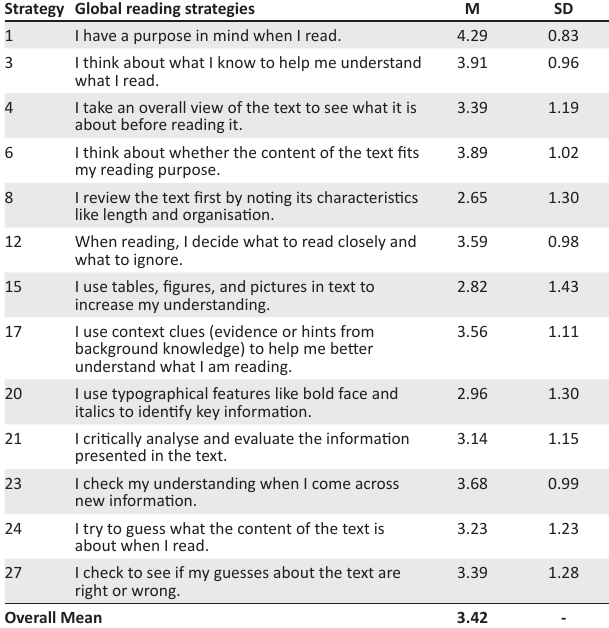
TABLE 4: Gobal reading strategies. Strategy Global reading